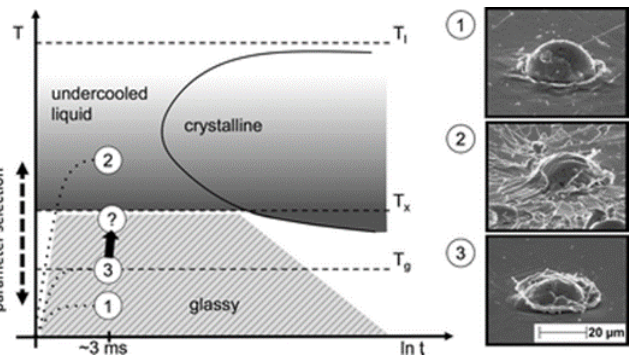
Figure 12. Amorphous metals schematic time temperature transformation (TTT) diagram. Reprinted with permission from [43] Copyright 2021 Springer .